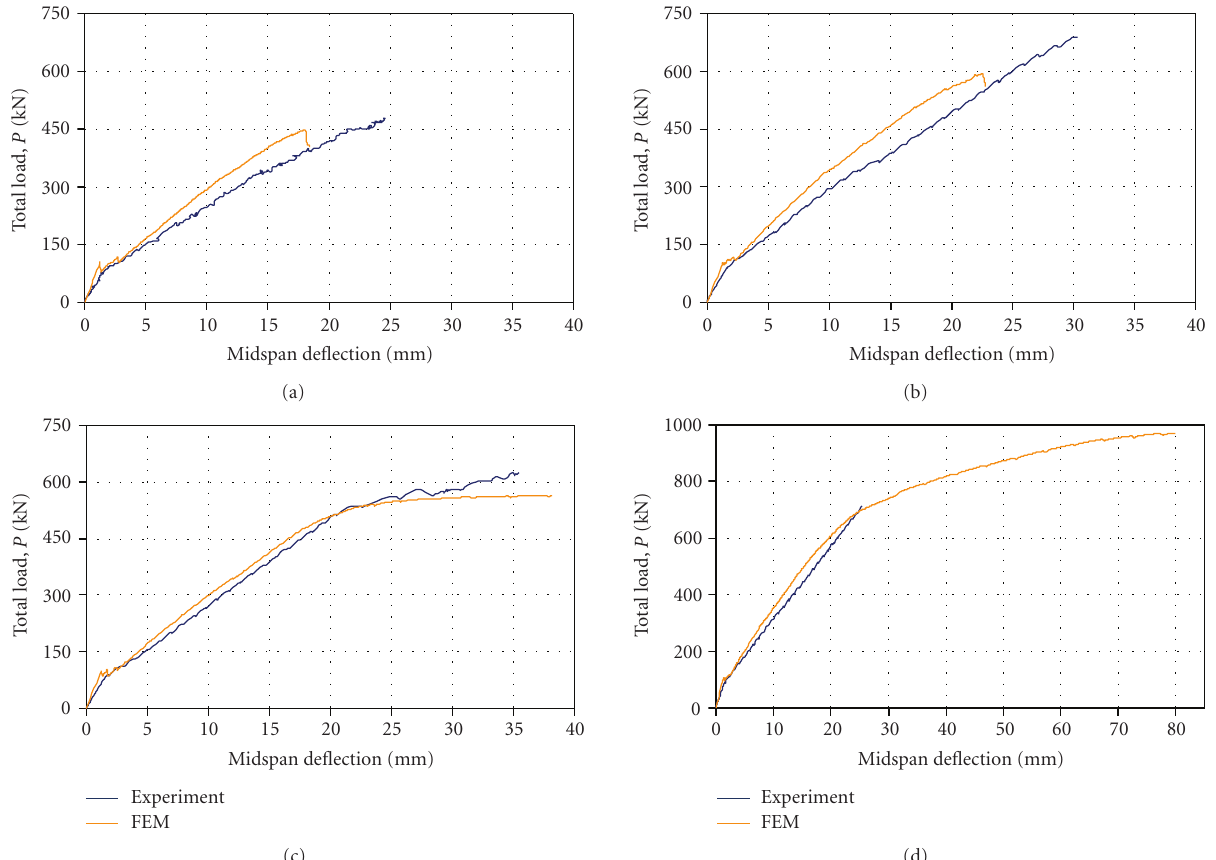
Figure 7: Load-deflection plots. (a) Unstrengthened beam; (b) flexural-strengthened beam; (c) shear-strengthened beam; (d) flexural plus shear-strengthened beam (experimental beam did not fail).